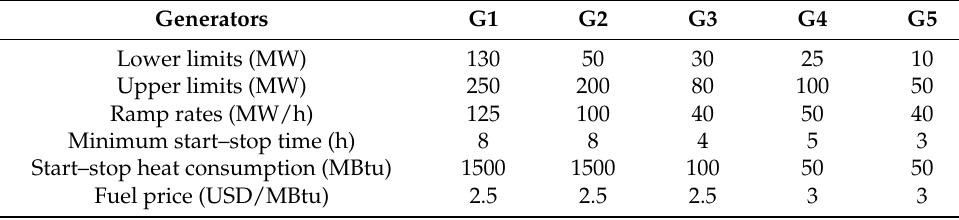
Table 1. Parameters of generators.